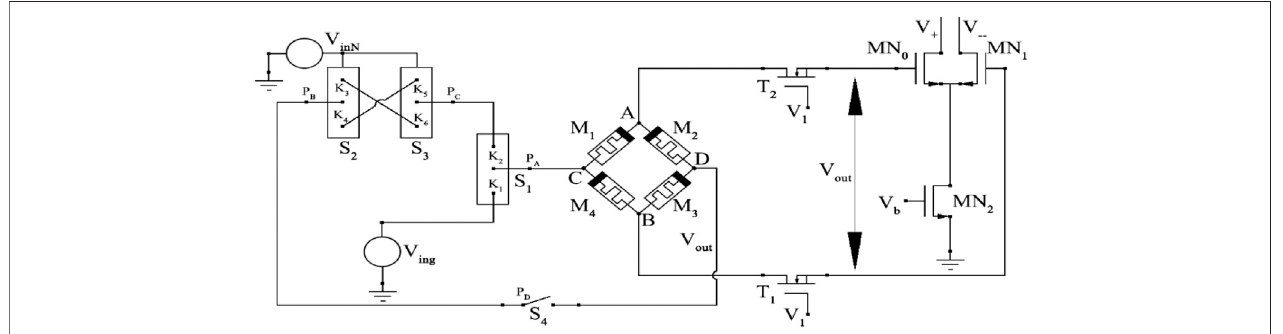
FIGURE 4 | Dual-mode memristor synaptic